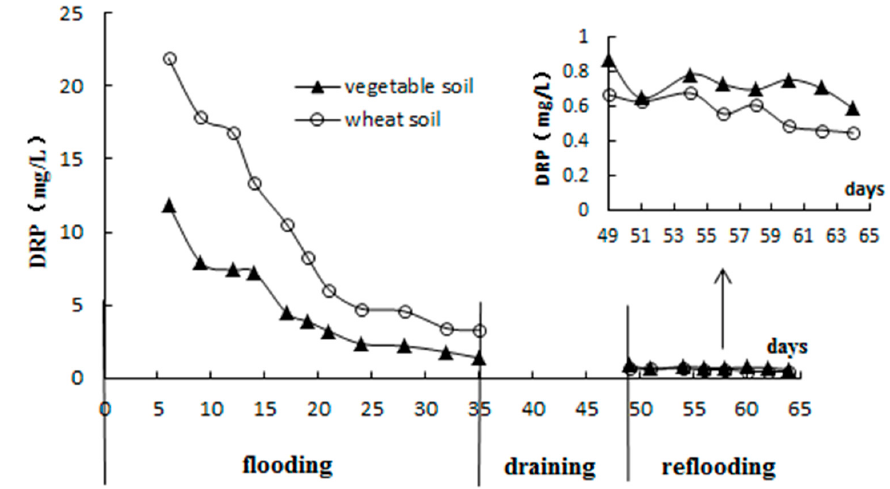
Figure 2. Changes of floodwater DRP in VS and WS over time (flooding period: days 0–35; draining period: days 36–48; reflooding period: days 49–64).